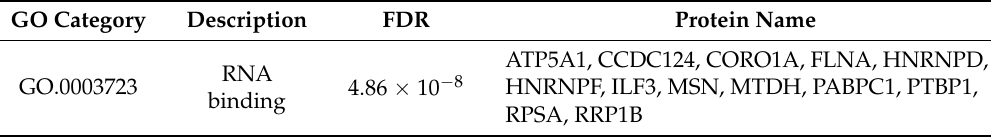
Table 2. STRING gene ontology for AtRA-regulated EZH2 interacting proteins.